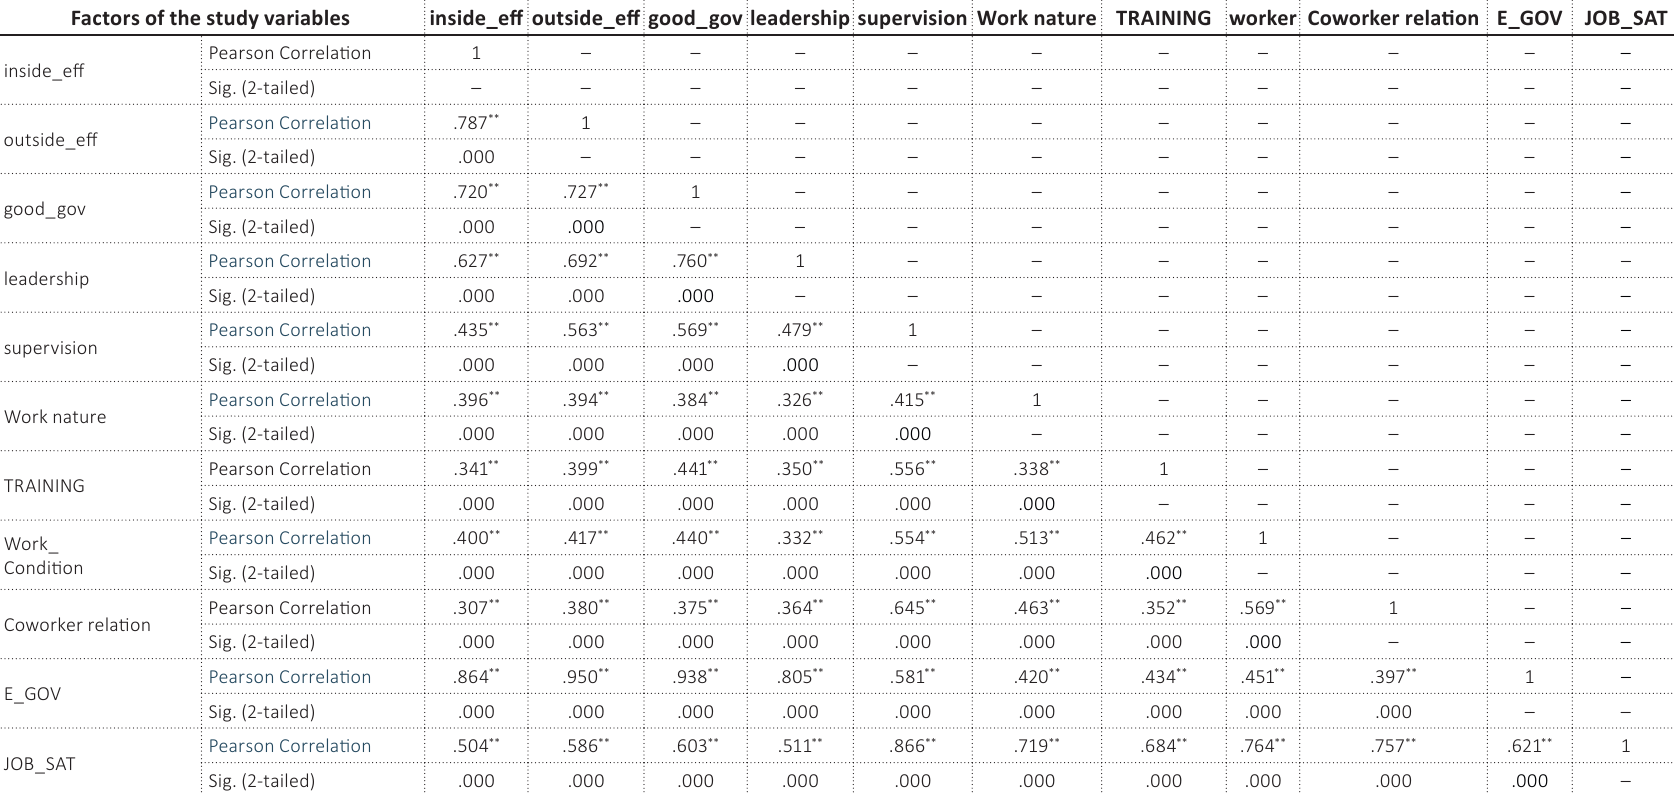
Table A2. Correlation matrix Factors of the study